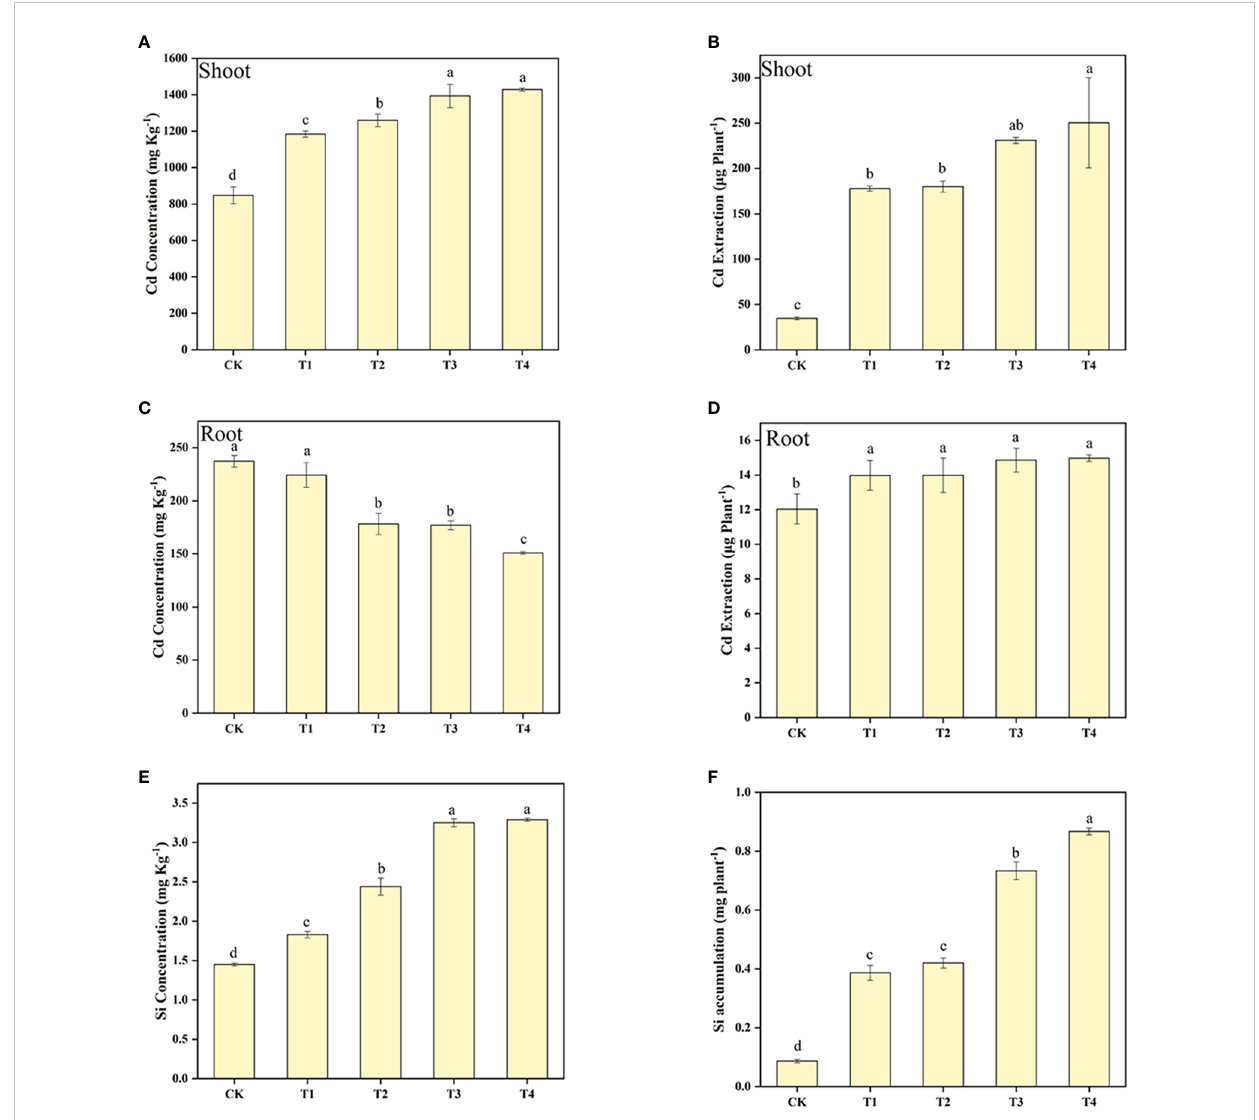
FIGURE 2 Shoot Cd concentration (A) , Shoot Cd accumulation (B) , root Cd concentration (C) , root Cd accumulation (D) , and Si concentration (E) , Si accumulation (F) of S. alfredii under different Si treatments. CK: control treatment, T1, T2, T3 and T4 were the Si concentrations of 0.5, 1.0, 1.5 and 2.0 mmol ∙ L -1 , respectively. Values are mean ± SD and columns denoted with different letters indicate signi fi cant differences between treatments at P <